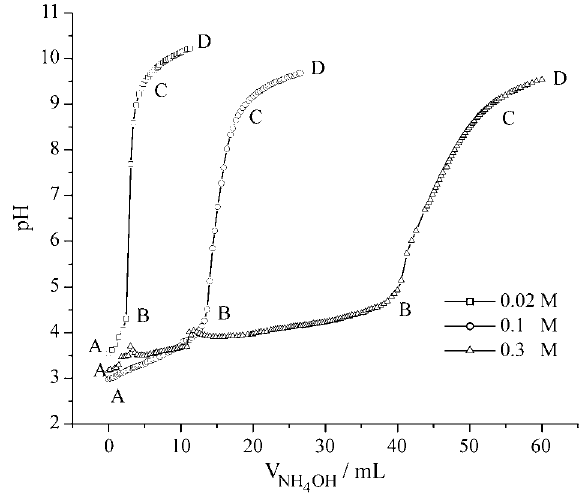
Figure 2. Curvas potenciométricas para diferentes concentraciones de Al 2 (SO 4 ) 3